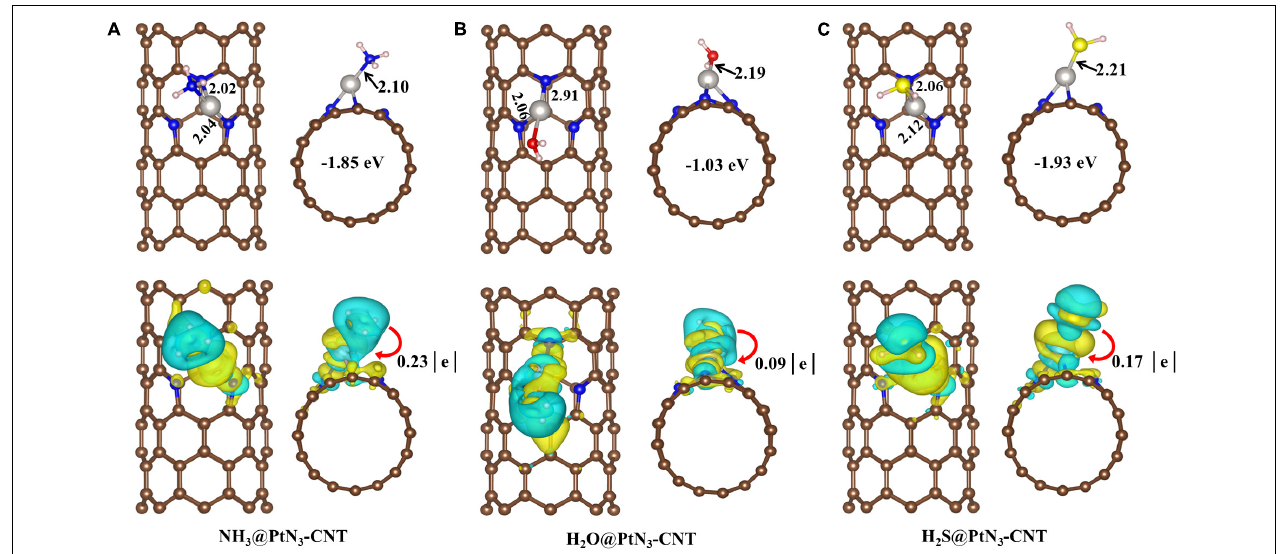
FIGURE 3 | Adsorption structures and deformation charge distribution of (A) NH 3 @PtN 3 -CNT system; (B) H 2 O@PtN 3 -CNT system; (C) H 2 S@PtN 3 -CNT system. Light pink ball represents H atom. The yellow area and cyan area represent the accumulation and consumption of electrons,